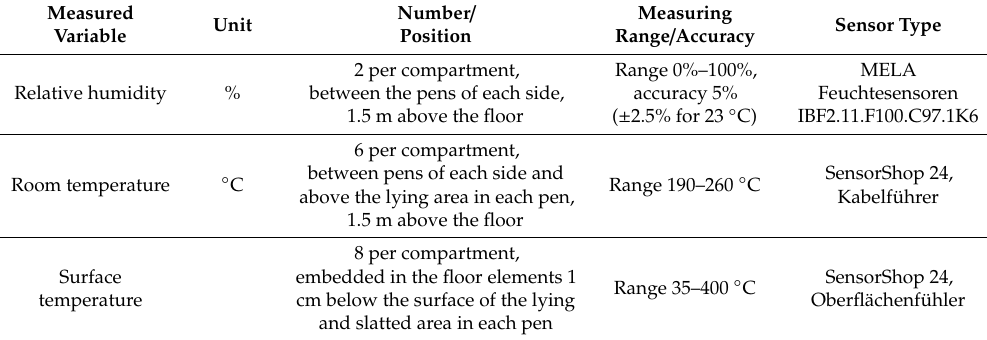
Table 1. Overview of the sensors used in this study. All sensors recorded data every minute.